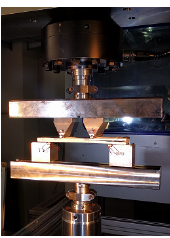
Figure 5. Mode I testing setup